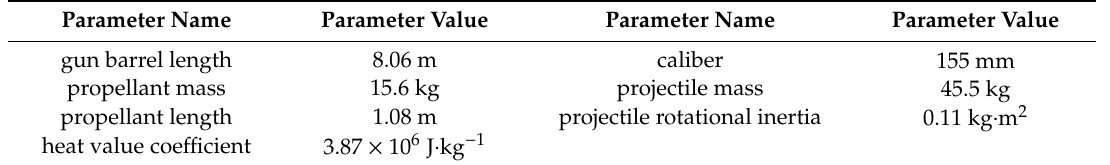
Table 1. Parameter values of propellant and mechanical structure.